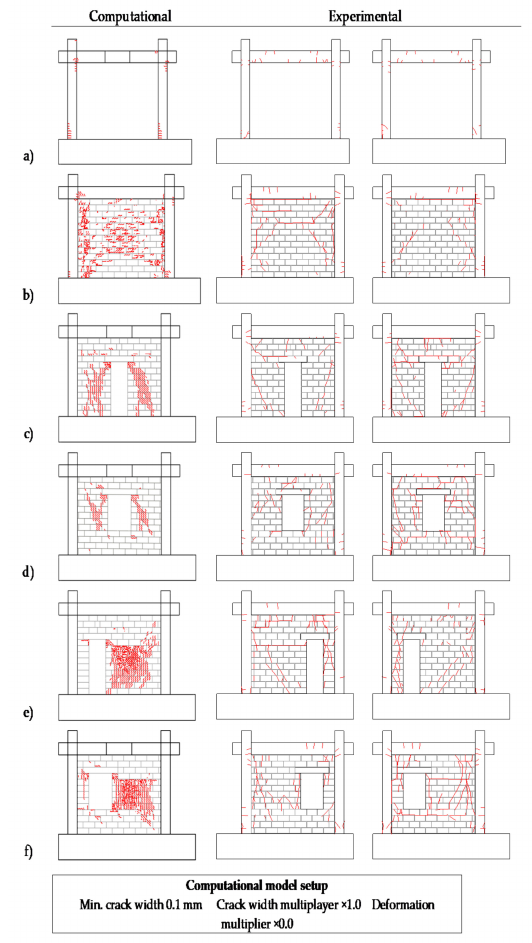
Figure 21. Crack patterns of IP experimental and computational models (results from models calibrated in both IP and OoP direction). ( a ) bare rc frame case; ( b ) full-infilled frame case; ( c ) centric door case; ( d ) centric window case; ( e ) eccentric door case; ( f ) eccentric window